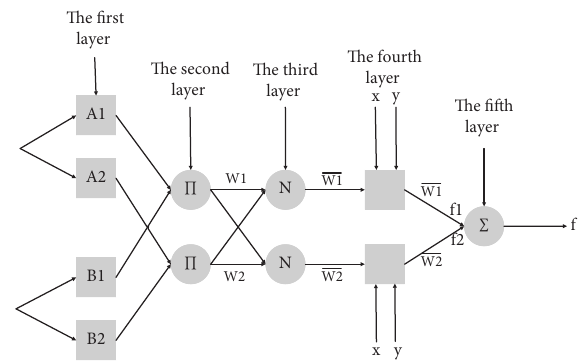
Figure 3: A research framework for granulation of time-series information.